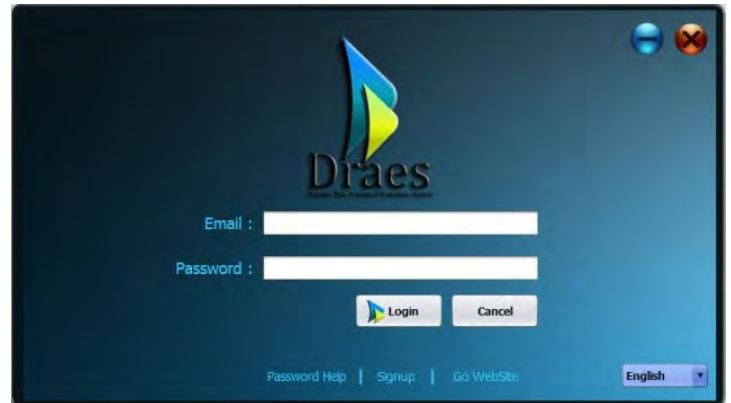
Figure 4. DRAES User Login Screen